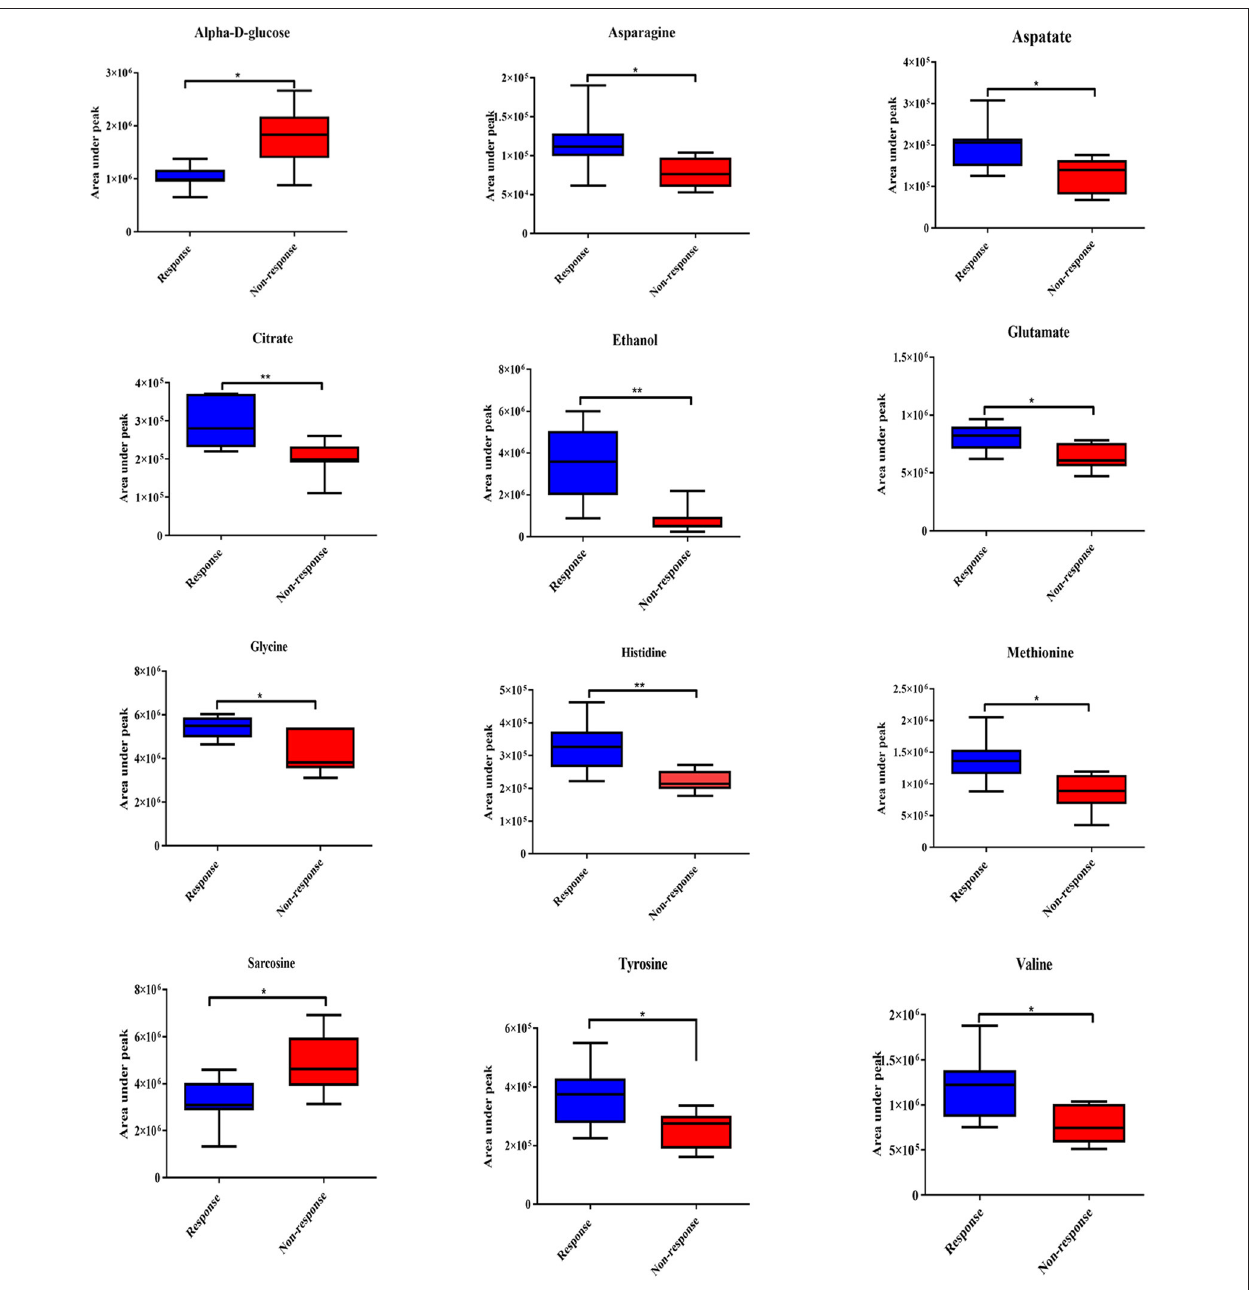
FIGURE 2 | Significantly changed metabolites in gemcitabine response patterns from tumor tissues of patients with CCA. The blue color shows response group and red color shows non-response group. * and ** indicate statistically significant p-value < 0.05 and p -value < 0.01, respectively.